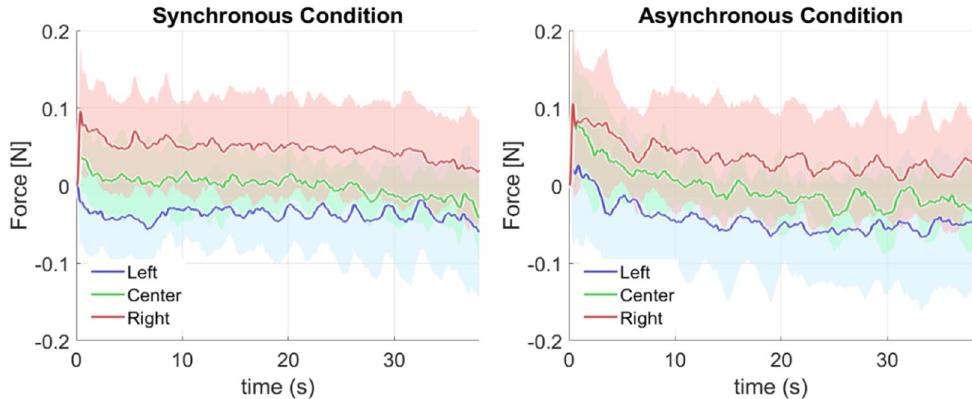
Figure 3. Average participant lateral force exerted during stimulation for the synchronous and asynchronous conditions. The profile is shown separately for the three experimental conditions, Left (blue), Center (green) and Right (red), with solid lines indicating the mean value across participants and the shaded region representing the standard deviation.